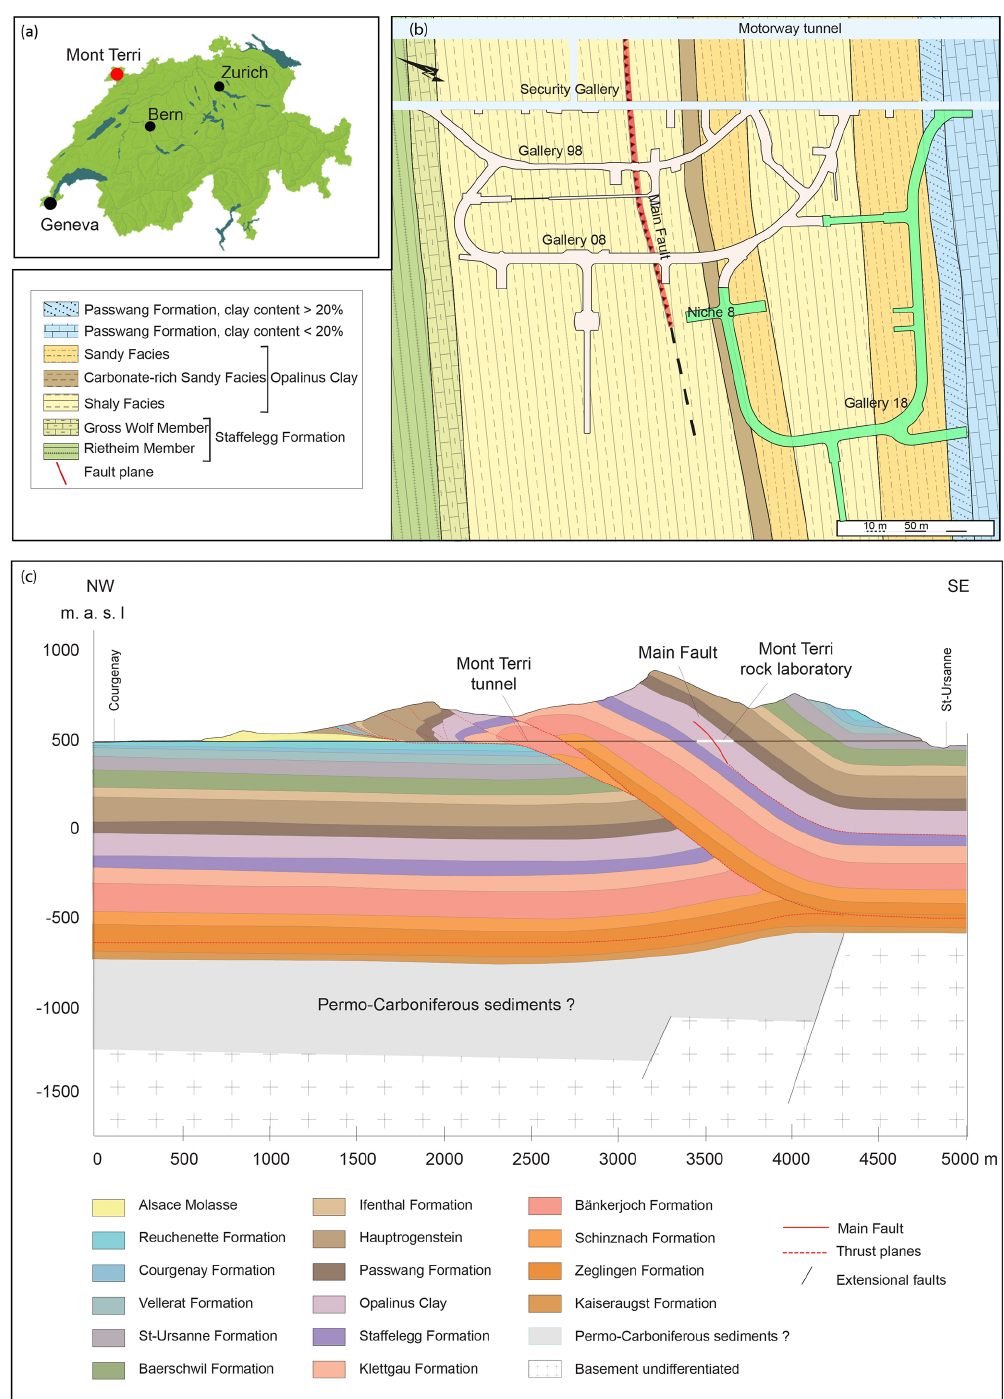
Figure 2. (a) Location of the MTRL. (b) Schematic geological map of the laboratory area with the new tunnels in light green (after Thury and Bossart, 1999). (c) Geological interpretation of the main structures along a profile crosscutting the security gallery (Nussbaum et al.,